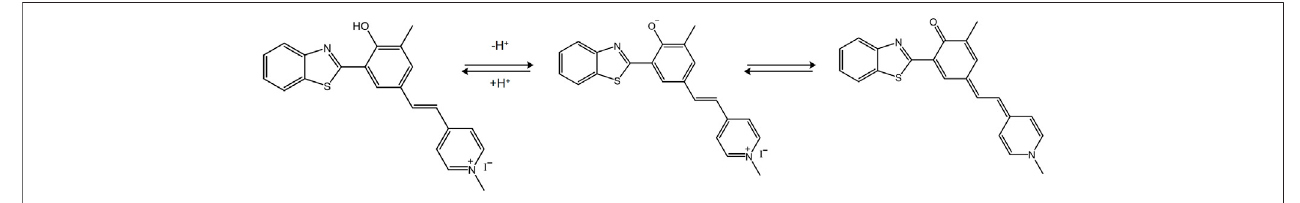
FIGURE 6 | The pH sensing mechanism for the probe HBTMP (Gaoqing et al.,